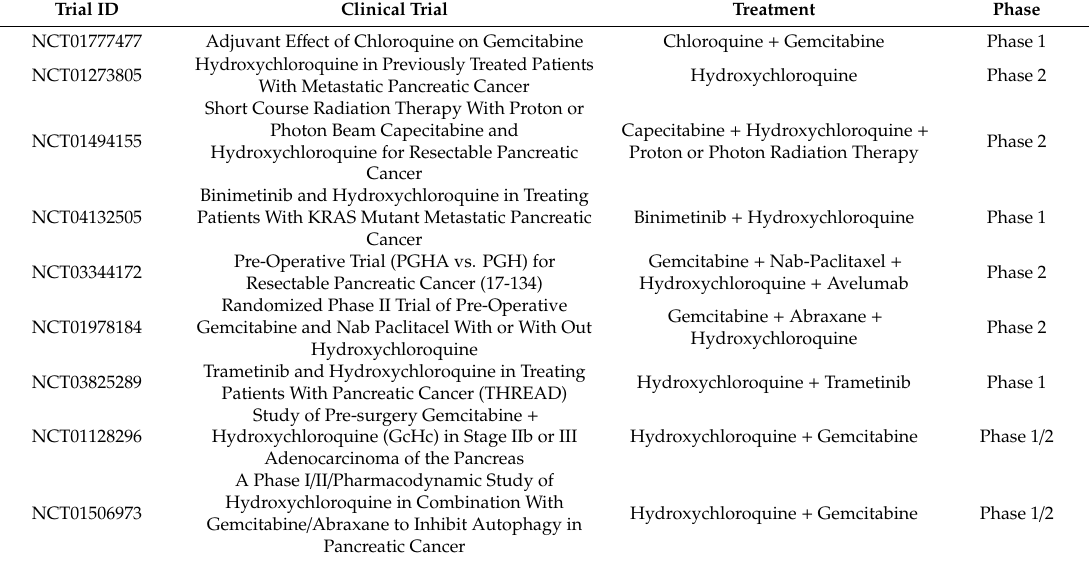
Table 1. Clinical trials aiming to target autophagy in pancreatic cancer